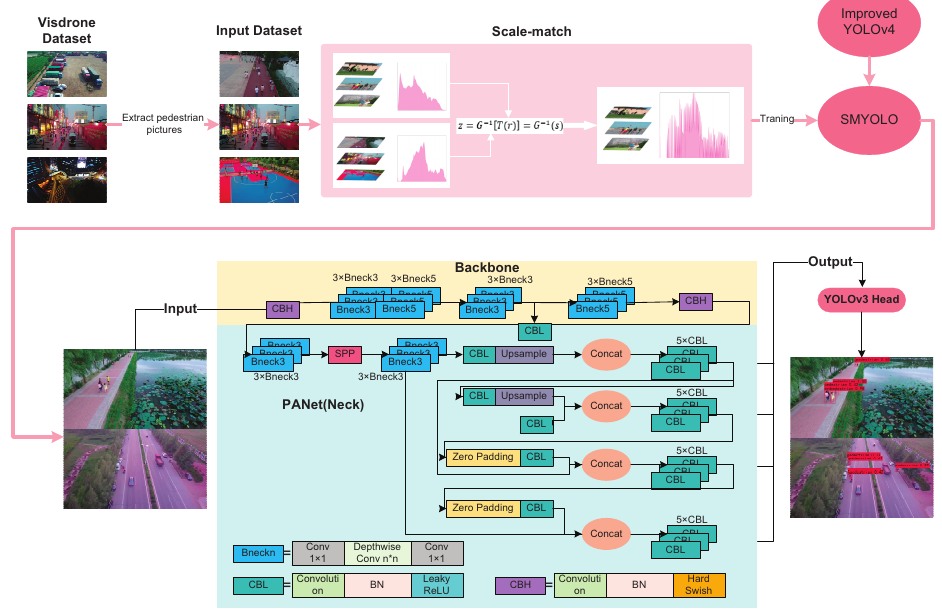
Figure 2. Low-altitude pedestrian detection algorithm flow